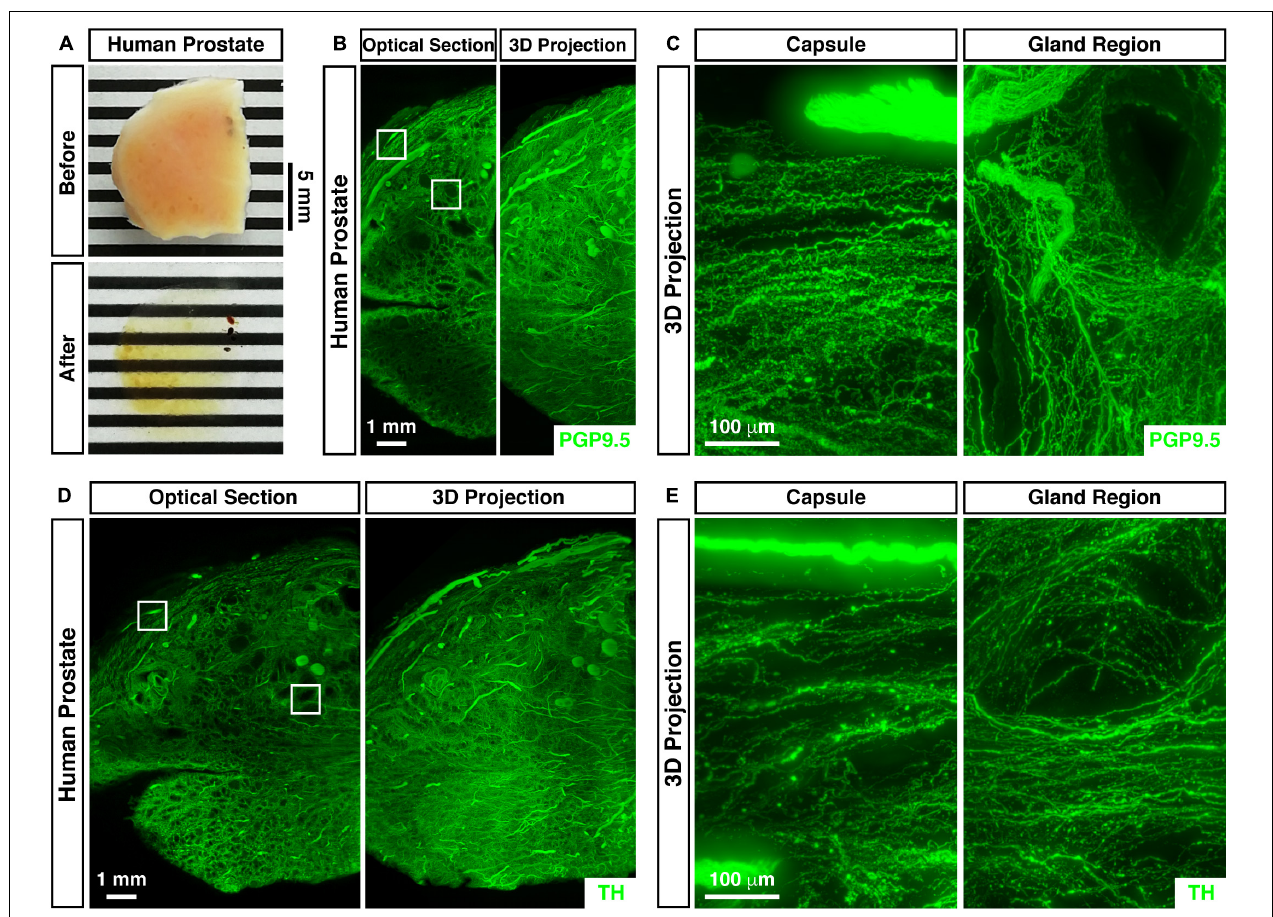
FIGURE 2 | 3D assessment of neural innervations in the human prostate. (A) The unsectioned prostate tissue of the adult human male before (upper panel) and after (lower panel) the whole-tissue immunolabeling and optical clearing. (B,C) 3D fluorescence imaging of neural innervations in the human prostate. The unsectioned prostate tissue of the adult human male was subjected to the whole-tissue PGP9.5-immunolabeling. (B) Representative optical section (left panel) and 3D projection (right panel) of the lightsheet imaging are shown. The squares denote the capsule or the gland region imaged at high magnification in panel (C) . (C) Representative 3D projections of the 1-mm thickness of the capsule (left panel) or the gland region (right panel) of the lightsheet imaging are shown. (D,E) 3D assessment of sympathetic innervations in the human prostate. The unsectioned prostate tissue of the adult human male was subjected to the whole-tissue TH-immunolabeling. (D) Representative optical section (left panel) and 3D projection (right panel) of the lightsheet imaging are shown. The squares denote the capsule or the gland region imaged at high magnification in panel (E) . (E) Representative 3D projections of the 1-mm thickness of the capsule (left panel) or the gland region (right panel) of the lightsheet imaging are